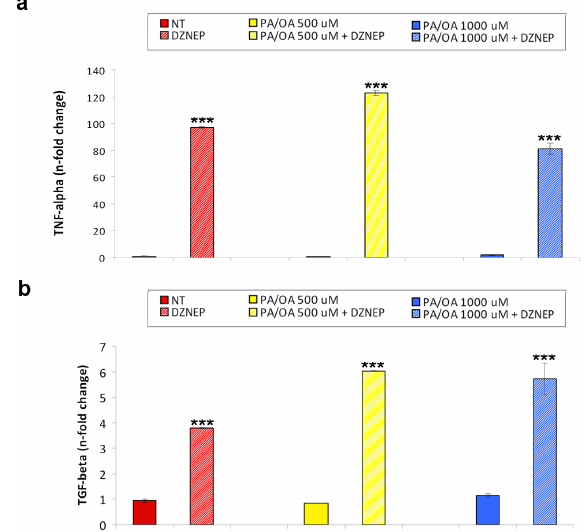
Figure 4. ( a ) TNF- α and ( b ) TGF- β mRNA expression levels in the HepG2 cells either normal or treated with 500 or 1000 µM PA/OA for 24 h after pre-treatment with DZNep. The histograms represent the mean ± SD of at least two independent experiments in triplicate. *** p < 0.001 vs . the respective